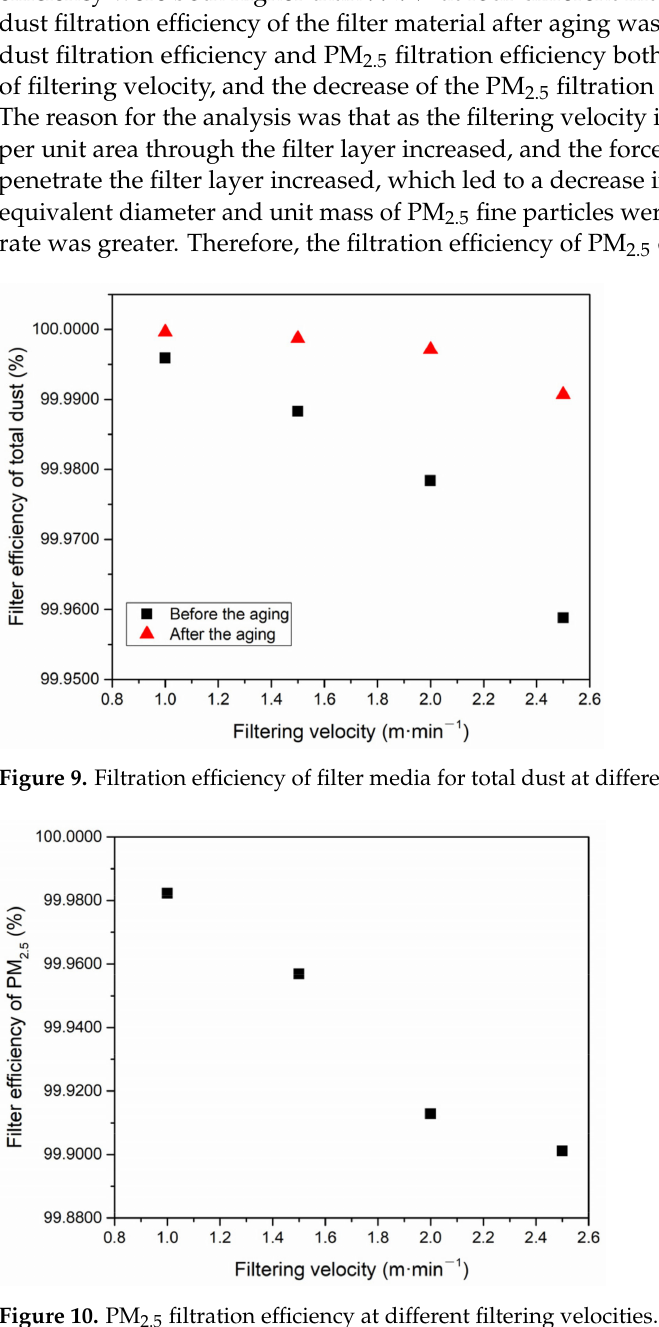
Figure 10. PM 2.5 filtration efficiency at different filtering